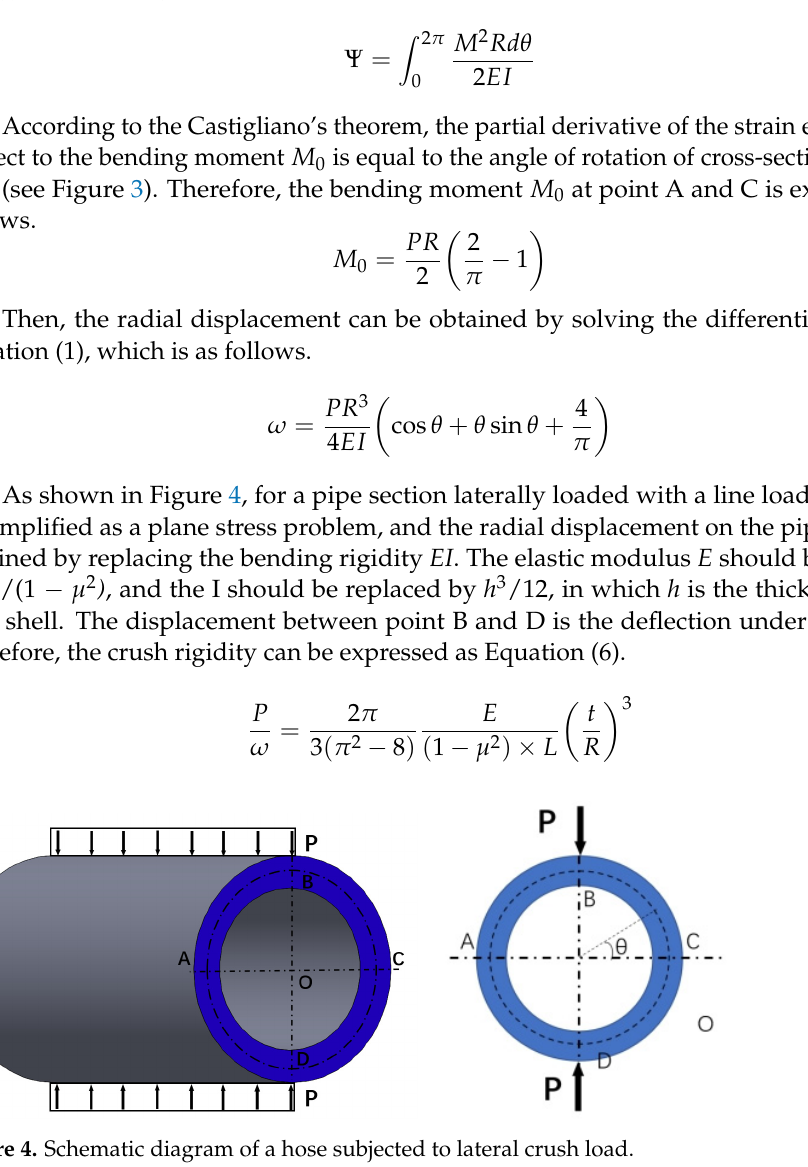
Figure 3. Schematic diagram of the mechanical model of a crushed ring.